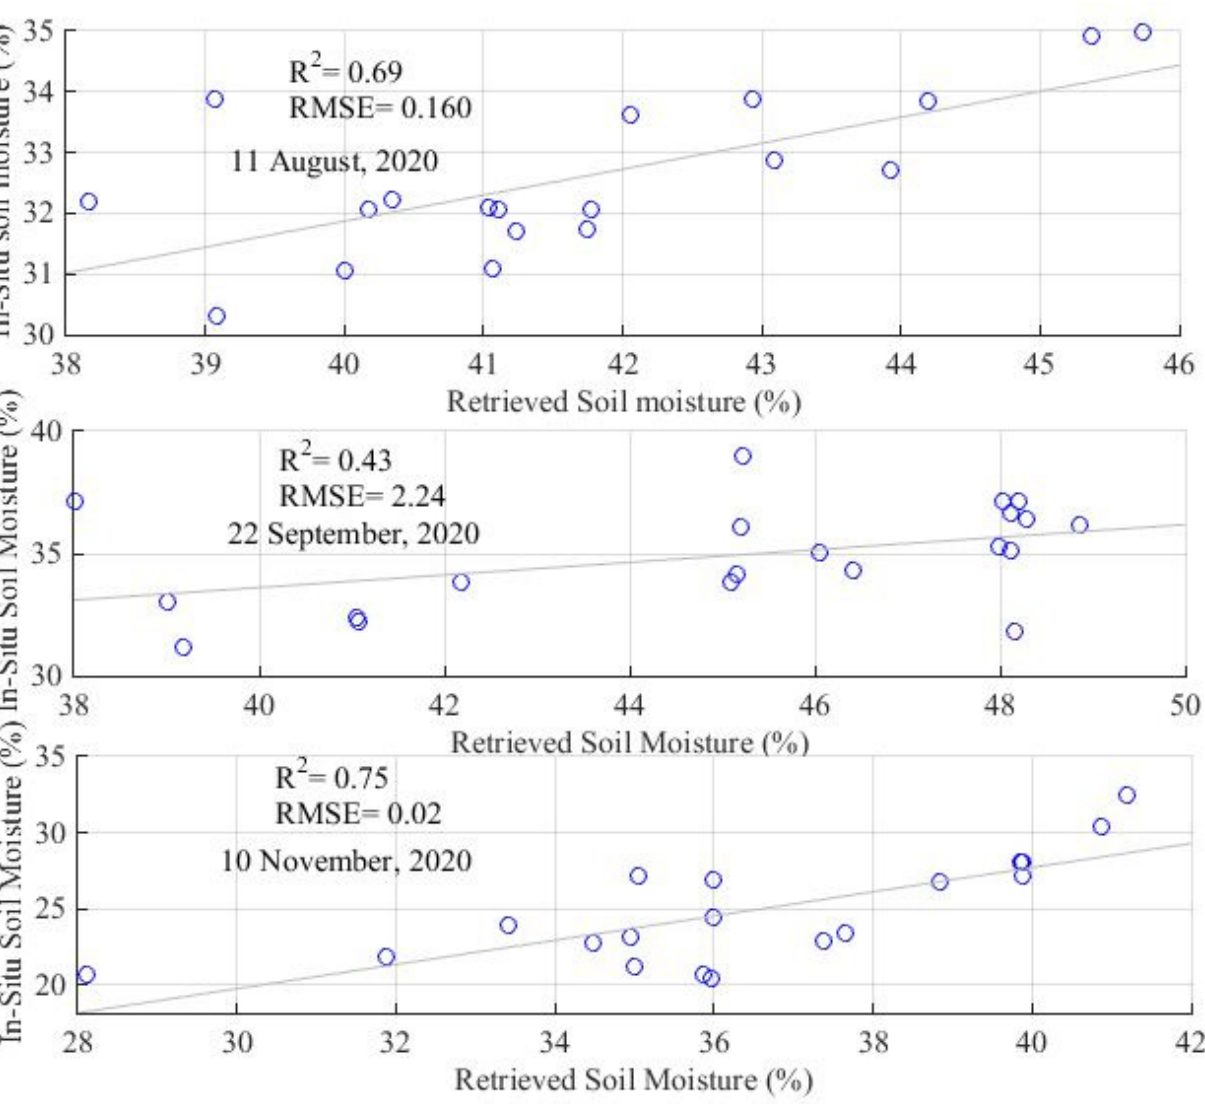
Figure 9. Correlation of in-situ soil moisture and WCM-based soil moisture estimate during the cropping season in Debre Mewi (SWC treated) watershed.